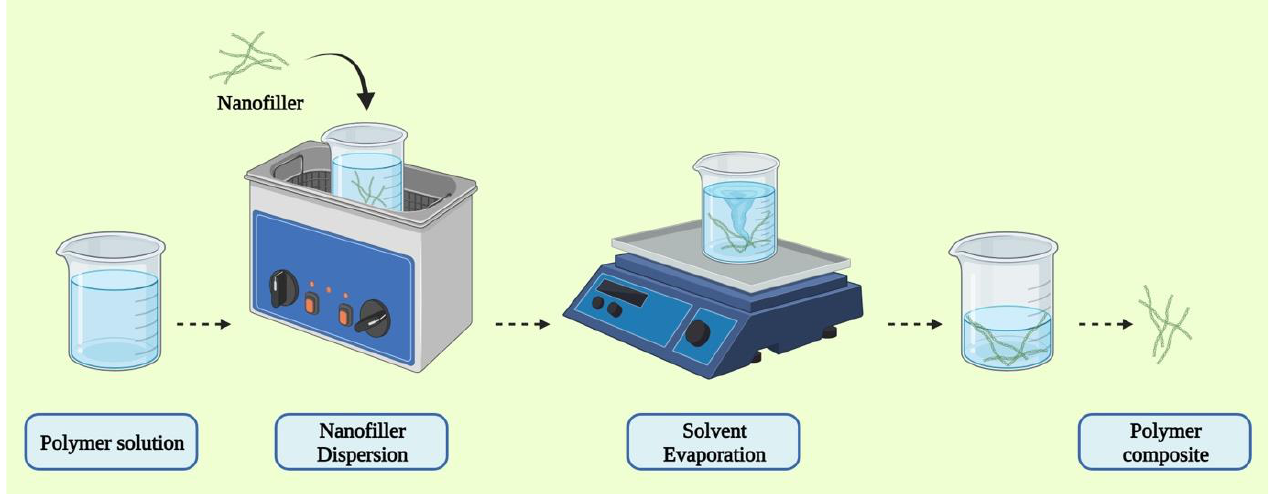
Figure 5. Schematic representation of solution mixing method of CP composites synthesis.